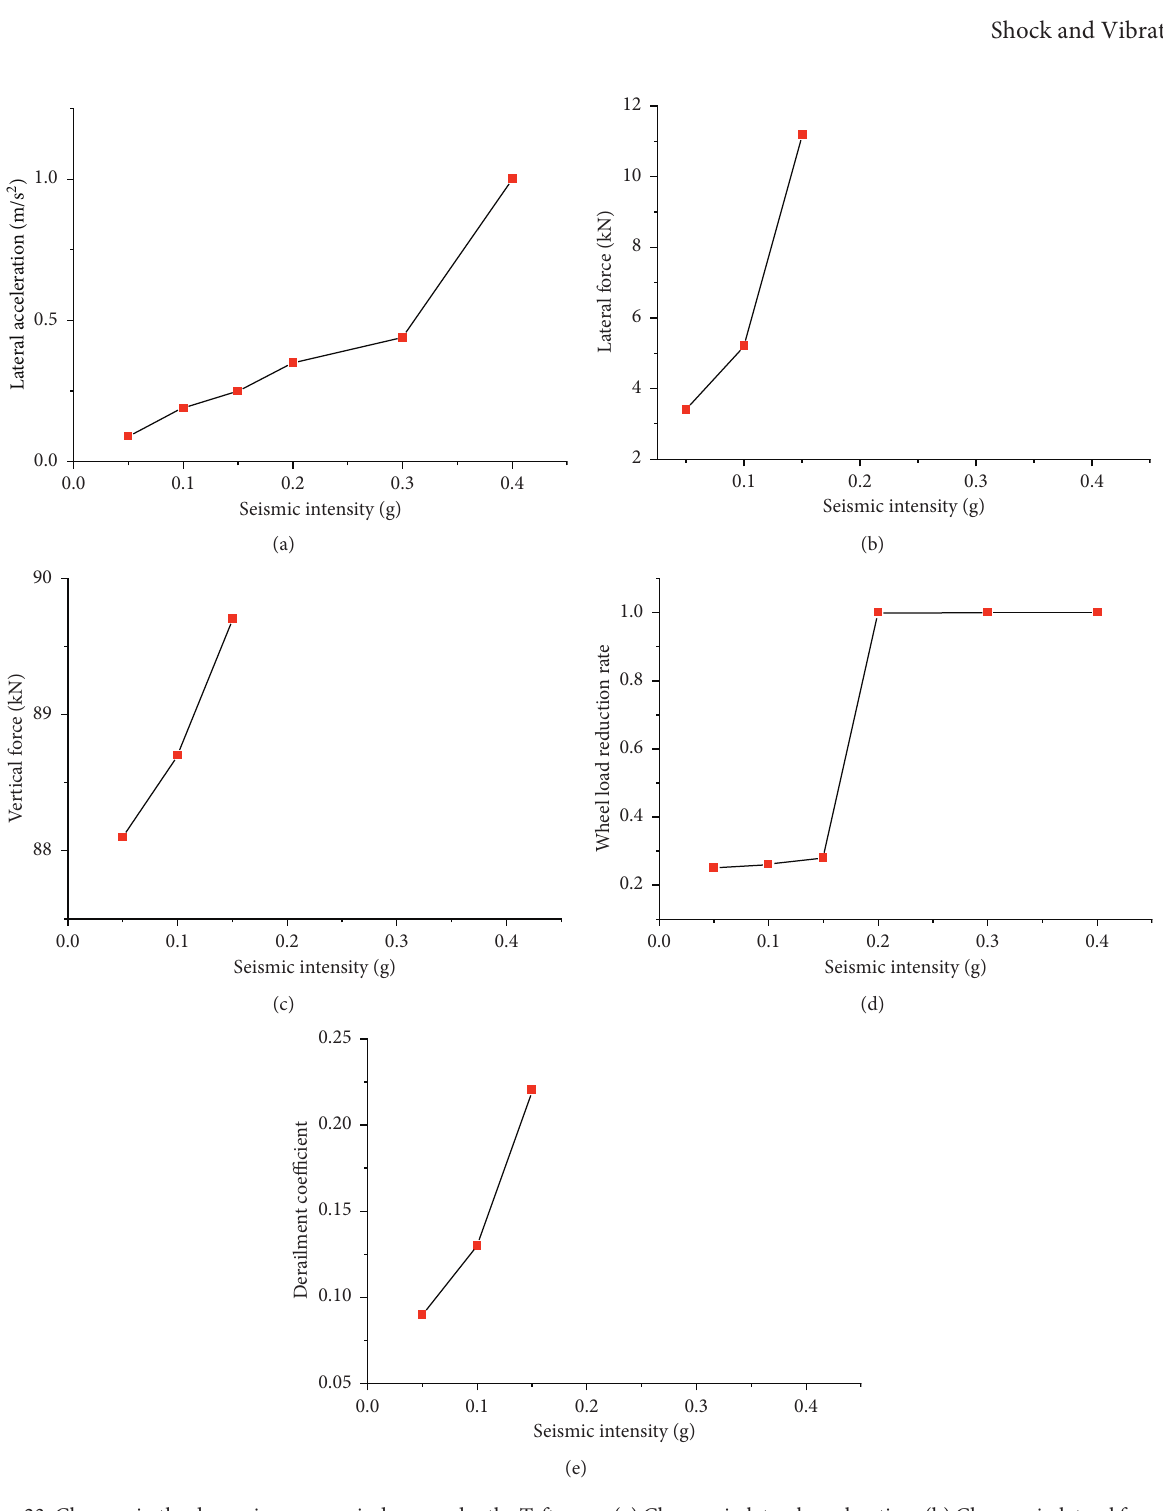
Under the action of the Qian’an wave, with increasing seismic intensity, the lateral acceleration, wheel-rail vertical force, and wheel load reduction rate increase approximately